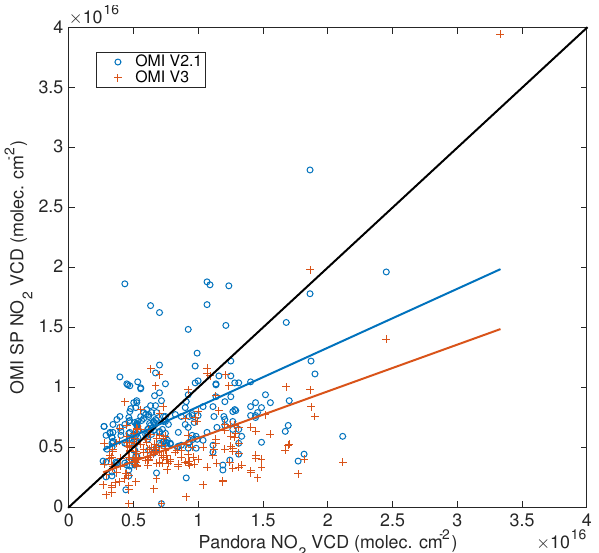
Pandora NO VCD (molec. cm ) 2 Figure 4. Scatter plot between OMI SP and Pandora NO 2 total col- umn in Helsinki during 2012. Both version 2.1 and 3 of the OMI SP retrievals are shown (blue circles and red crosses, respectively), together with the corresponding linear fit (blue and red lines, re- spectively). The 1:1 line is indicated in black. Only pixels with cross-track position 6–55 are